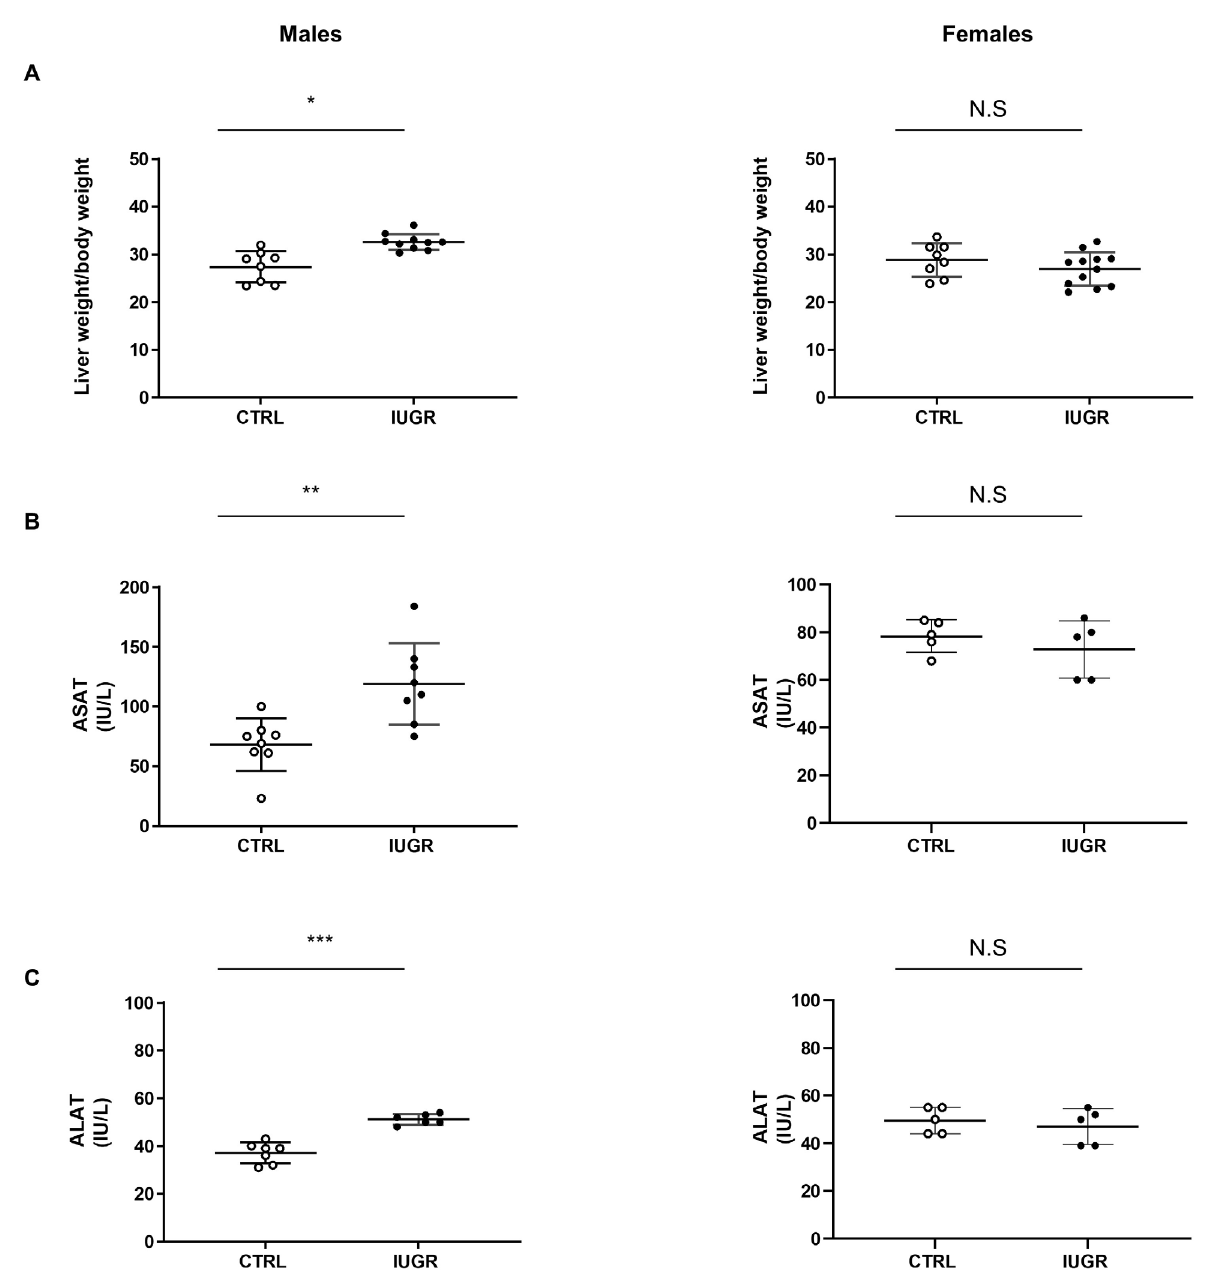
Figure 2. Liver weight and transaminase levels in IUGR and CTRL males and females at 6 months of age. Liver to bodyweight ratio ( A ) ( n = 8–12 animals/group/sex), plasma levels of aspartate aminotransferase (ASAT) ( B ) and alanine aminotransferase (ALAT) ( C ) ( n = 5–8 animals/group/sex) were measured in males and females. * p < 0.05; ** p < 0.01; *** p < 0.001; N.S: not significant.